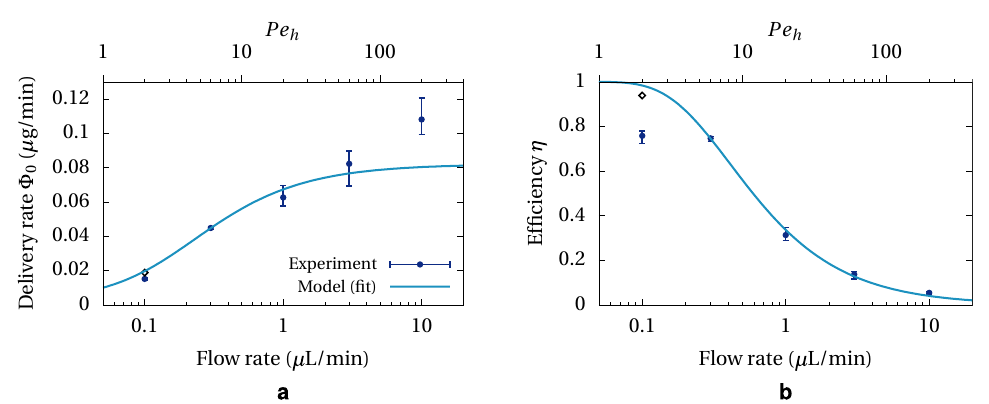
Figure 7. Delivery performance as function of flow rate and comparison with fitted model (Eq. 10). Points ( show average over triplicates, error bars show min and max values. The diamond ( upside-down cuvette and probe. ( a ) Stead-state delivery rate; ( b ) Delivery